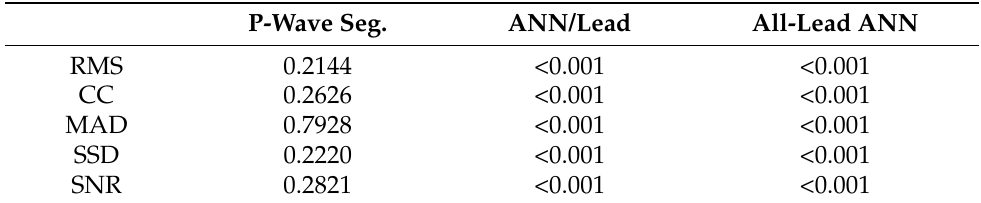
Table 1. p -values of the independence test between the control reconstruction algorithm, the Linear Regression, and the rest of the ECG reconstruction algorithms.